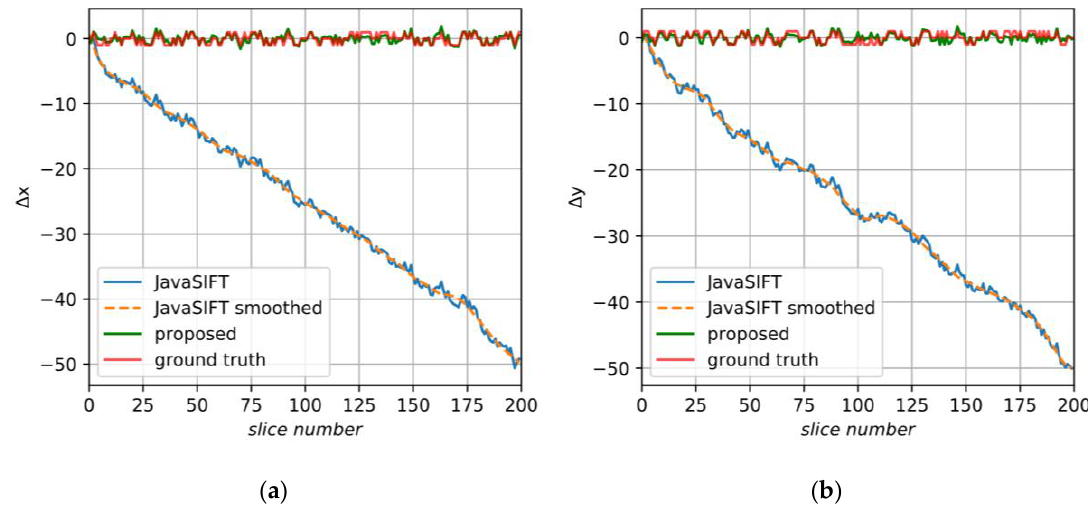
( b ) Figure 12. The displacements calculated by existing alignment algorithms for the synthetic sample: ( a ) in the X axis; ( b ) in the Y axis.